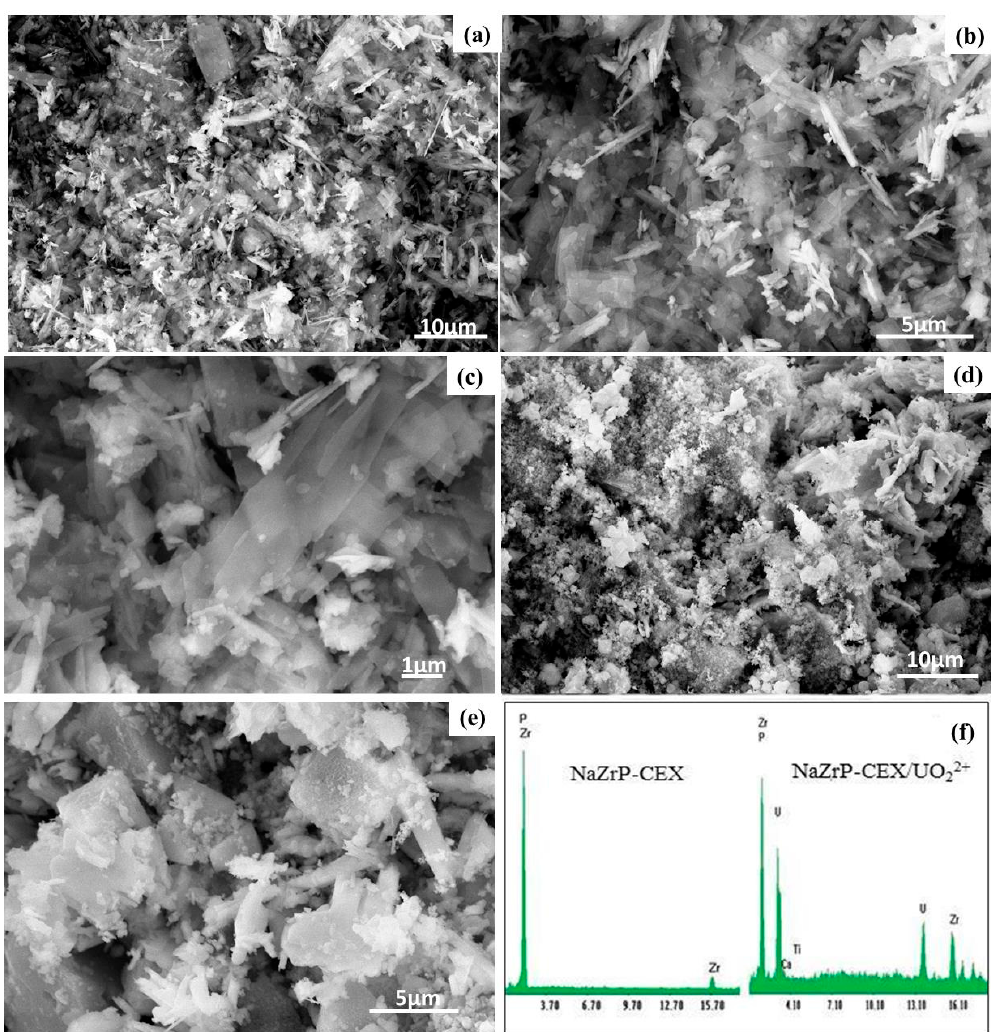
Figure 3. Scanning Electron Microscope (SEM) images of the fabricated mesoporous NaZrP-CEX with different magnifications ( a - c ), NaZrP-CEX loaded uranyl ions ( d , e ), and EDX analysis of NaZrP-CEX and NaZrP-CEX loaded uranyl ions ( f ).